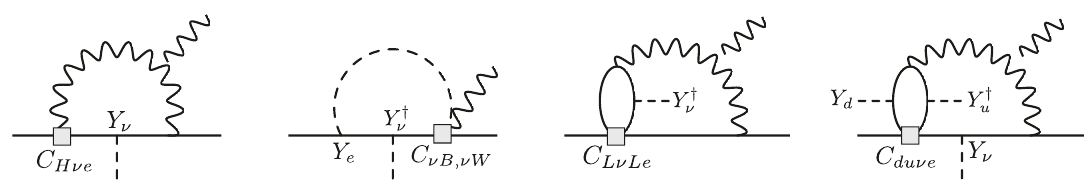
Figure 1 . Examples of the contribution from the dim-6 operators to ∆ a l . The gray box represents an insertion of a ν SMEFT operator. The solid line corresponds to fermions, while dashed and wavy lines denote the SU(2) Higgs doublet and a SM gauge boson,